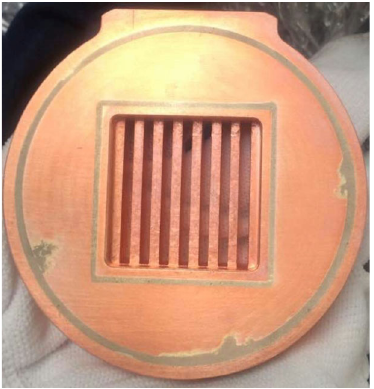
FIG. 10. Multi-slit aperture for the verification